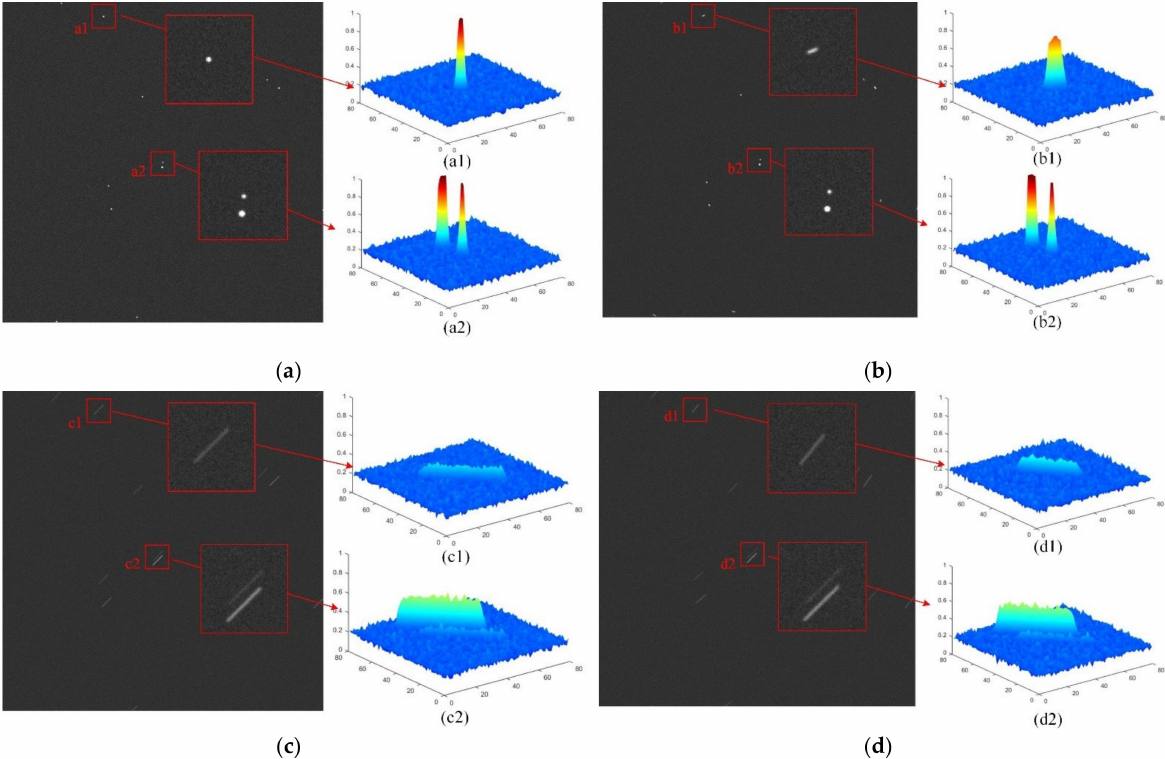
Figure 1. Partially enlarged 3D surface diagrams of smearing star images with different motion states, where the angular velocity of ( a ) is 0 ◦ /s so the image is static. The images in ( b – d ) are dynamic in different angular velocity. ( b ) is with the angular velocity of rolling, ( c ) has the angular velocity of two axes, and ( d ) has the angular velocity of three axes. ( a1 , b1 , c1 , d1 ) are enlarged diagrams at a star far from the center of FOV. ( a2 , b2 , c2 , d2 ) are near the center. The background noise of the simulated image is Gaussian random noise with a variance of 0.001 and the average background brightness is